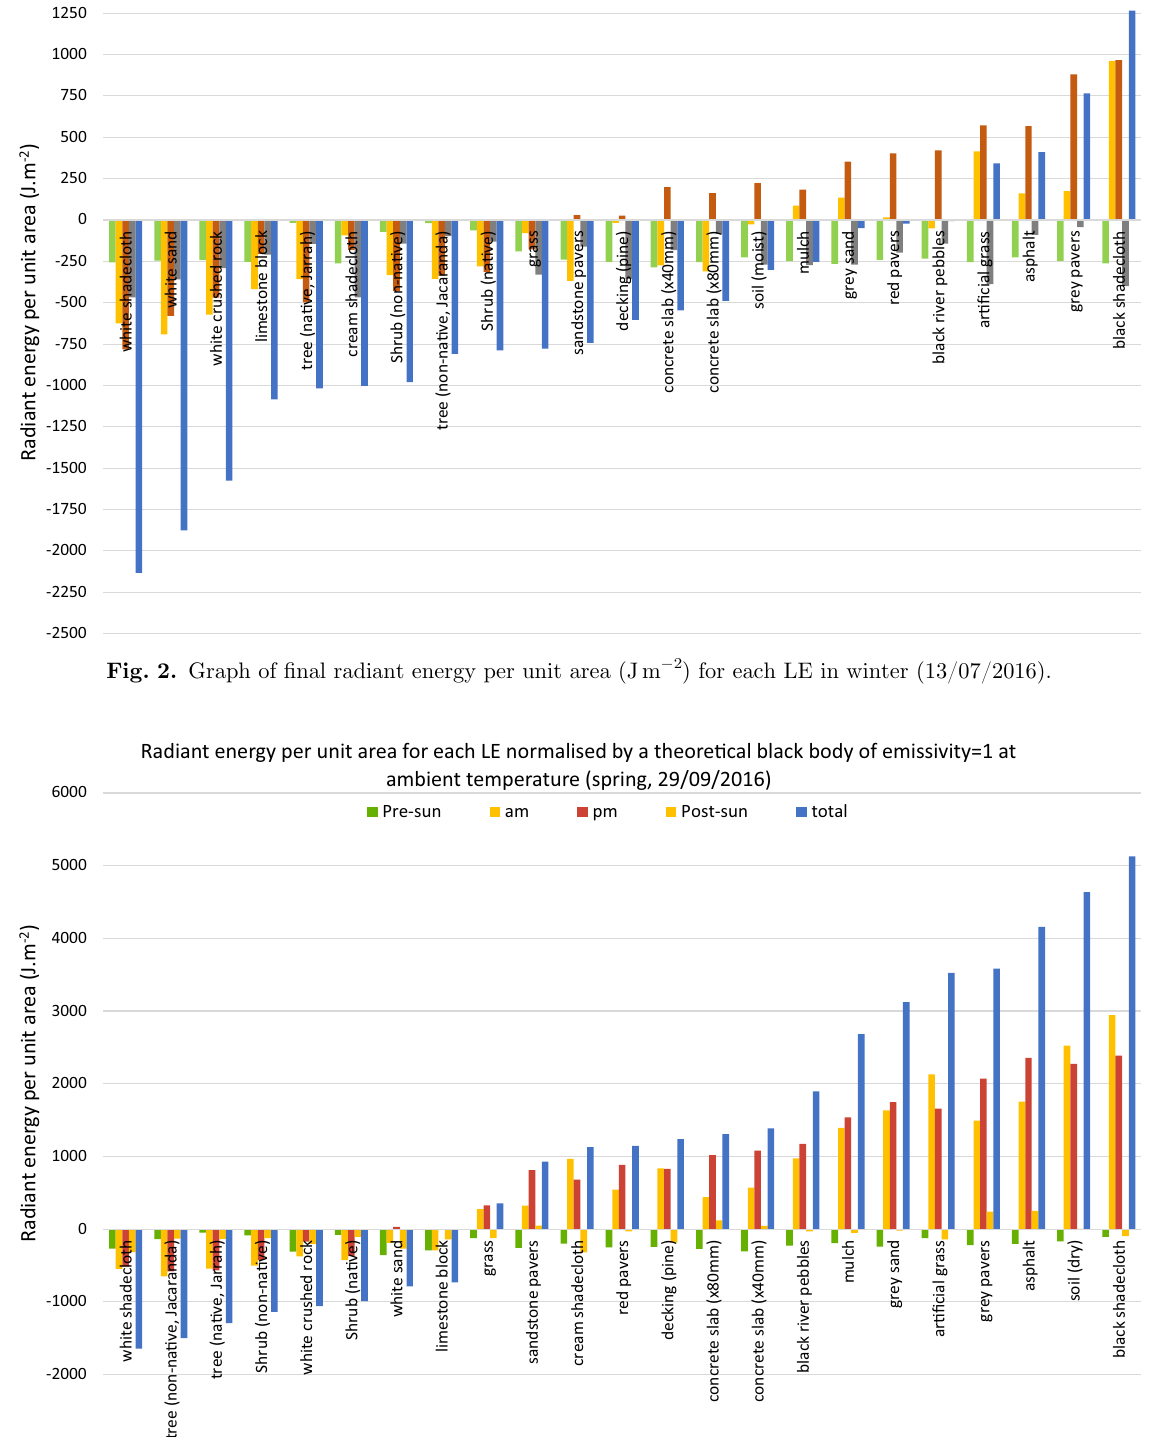
Fig. 3. Graph of fi nal radiant energy per unit area (J m (cid:1) 2 ) for each LE in spring